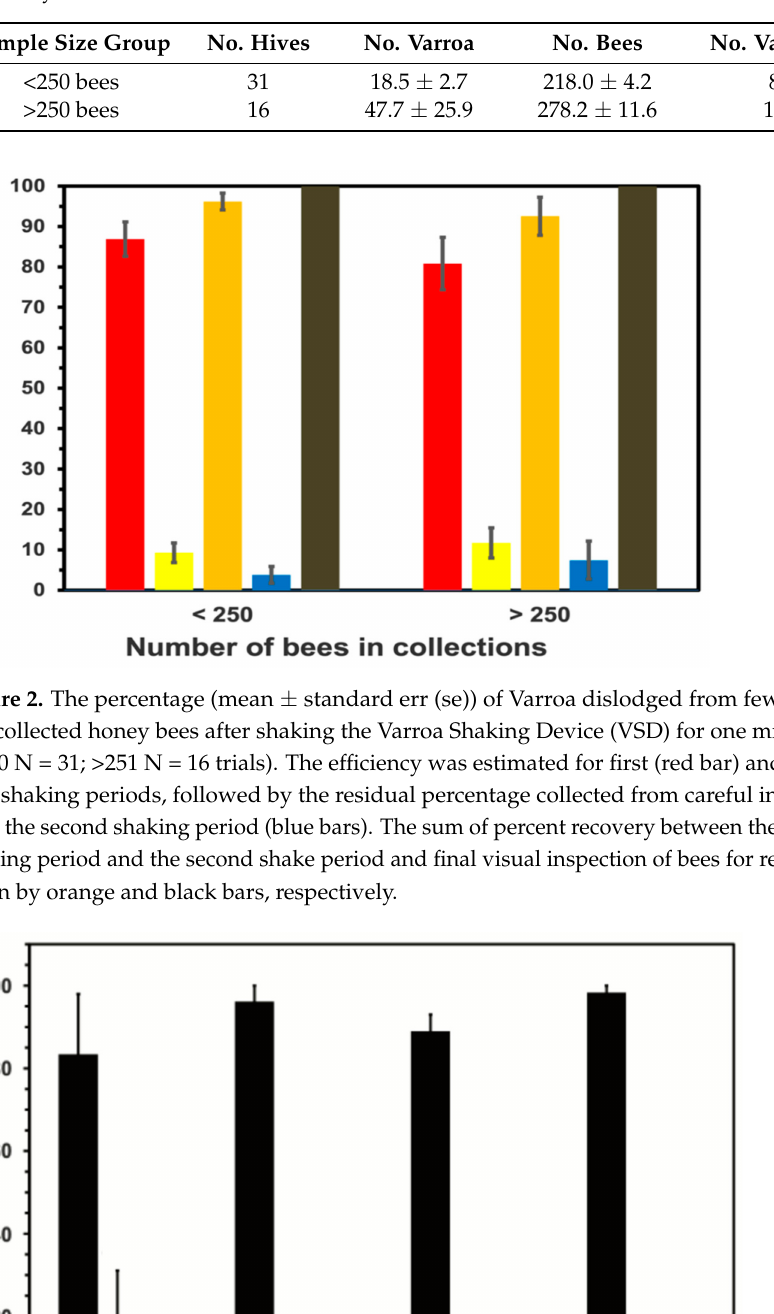
Table 2. Summary statistics for tests of sample size (number of bees) on estimation of Varroa recovery efficiency. The numbers (mean ± standard err (se)) of Varroa collected in each of the bee samples, the number of bees in each sample, and number of mites adjusted as the number of mites per 100 honey bees.